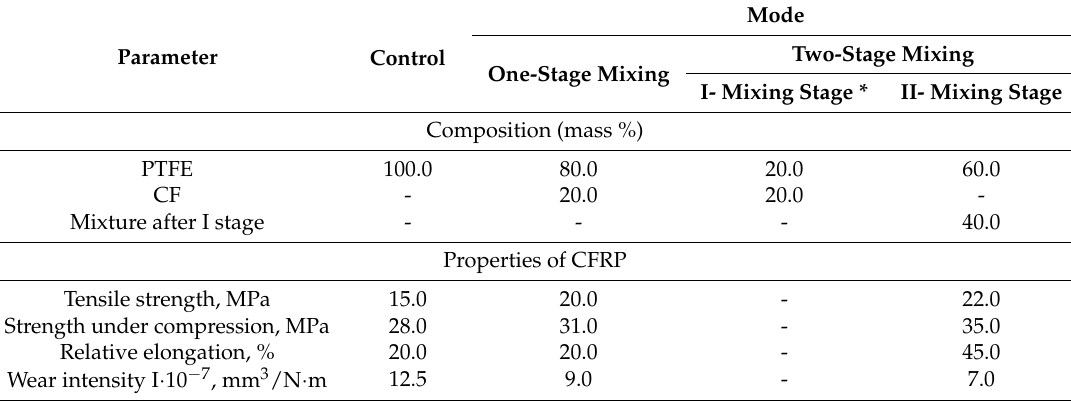
Table 9. Composition and properties of CFRP in one- and two-stage mixing